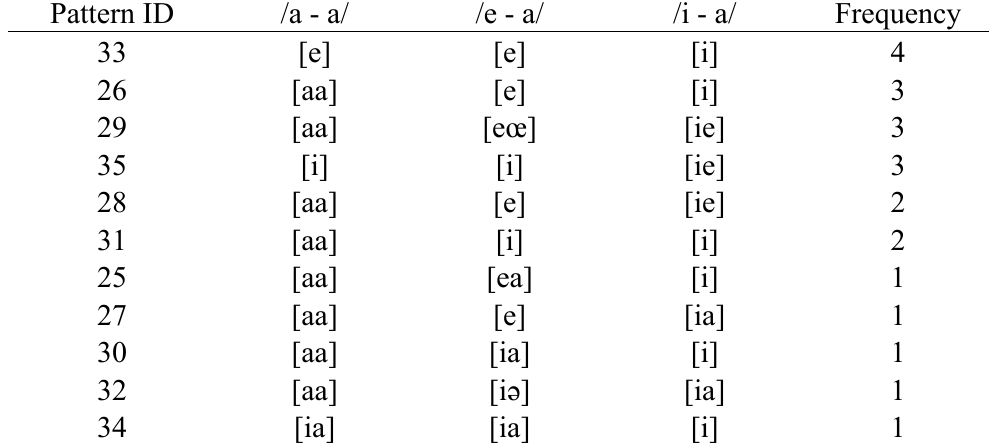
Table 2 . Patterns that depart from the 24 basic